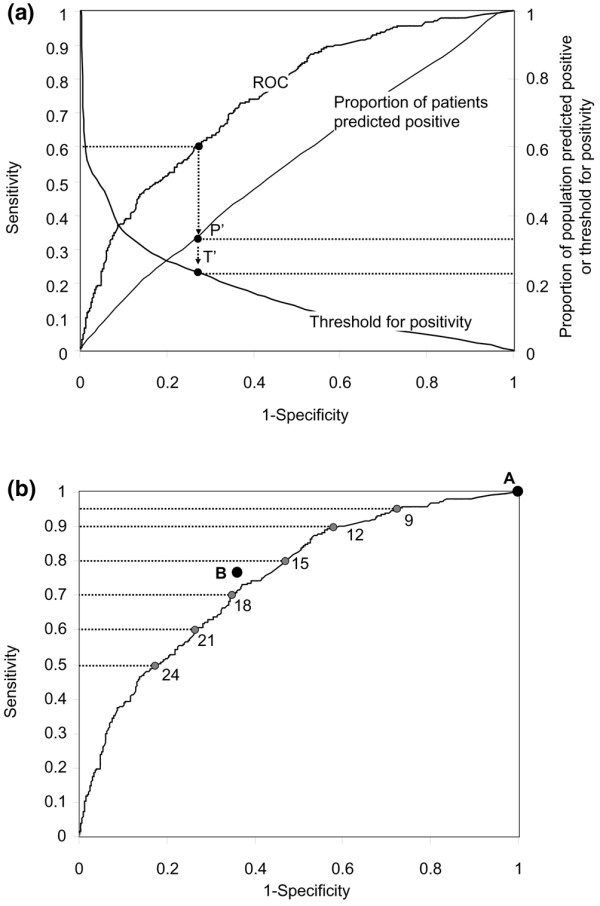
Receiver operating characteristics of late anemia prediction model and correspondence with point system. (a) The receiver operating characteristic (ROC) of the model predicting late anemia. Higher sensitivity (S) is associated with a lower threshold for positivity (T', probability of meeting criteria for late anemia). Accordingly, a higher proportion of the population will be declared to meet late anemia criteria (P') as specificity decreases. For example, a desired sensitivity of 60% would entail declaring a threshold for positivity corresponding to a probability of late anemia of 22% or more (T'). This results in 34% of the population exceeding this predicted probability and thus at risk for late anemia (P'). (b) Correspondence between intensive care unit (ICU) anemia points (see the text) and the ROC curve. Determining a lower point threshold of unacceptable risk of late anemia entails a trade-off between higher sensitivity and the willingness to declare a higher proportion of the population at risk. Setting a threshold of 21 points, which would achieve a sensitivity of 60% in identifying patients meeting criteria for late anemia, would result in considering intervention in 34% of the population (a). On the assumption that the proposed intervention is recombinant human erythropoietin, considering all ICU patients for treatment would result in 100% sensitivity, but no specificity (point A). Using inclusion criteria for the Corwin study results in 77% sensitivity and 65% specificity as illustrated by point B (see the text and Table 4), which is comparable to the point-based system. The ICU anemia score permits earlier intervention with comparable predictive power.